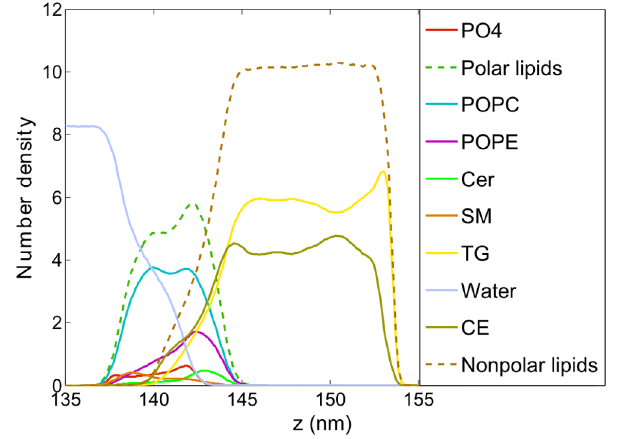
Figure 5. Density profiles of individual system components at APPL=45 A˚ 2 under equilibrium. The data are averaged over the